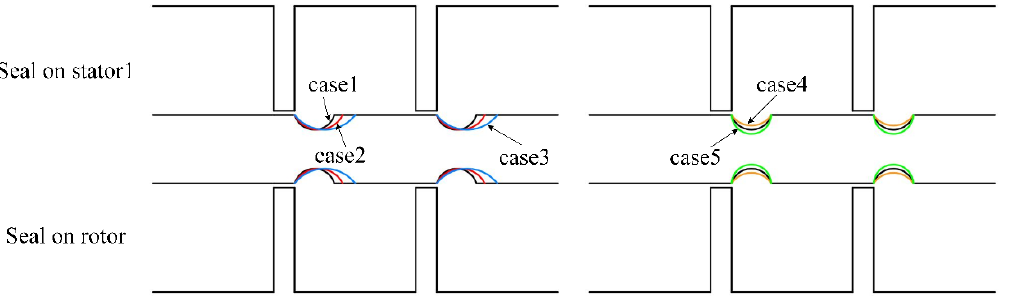
Figure 15. Profiles of five cases.